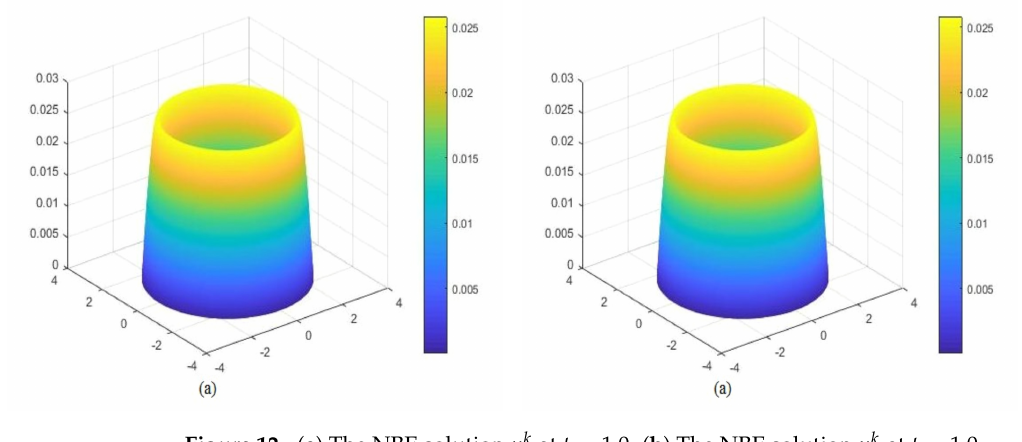
Figure 12. ( a ) The NBE solution u k at t = 1.0. ( b ) The NBE solution u k